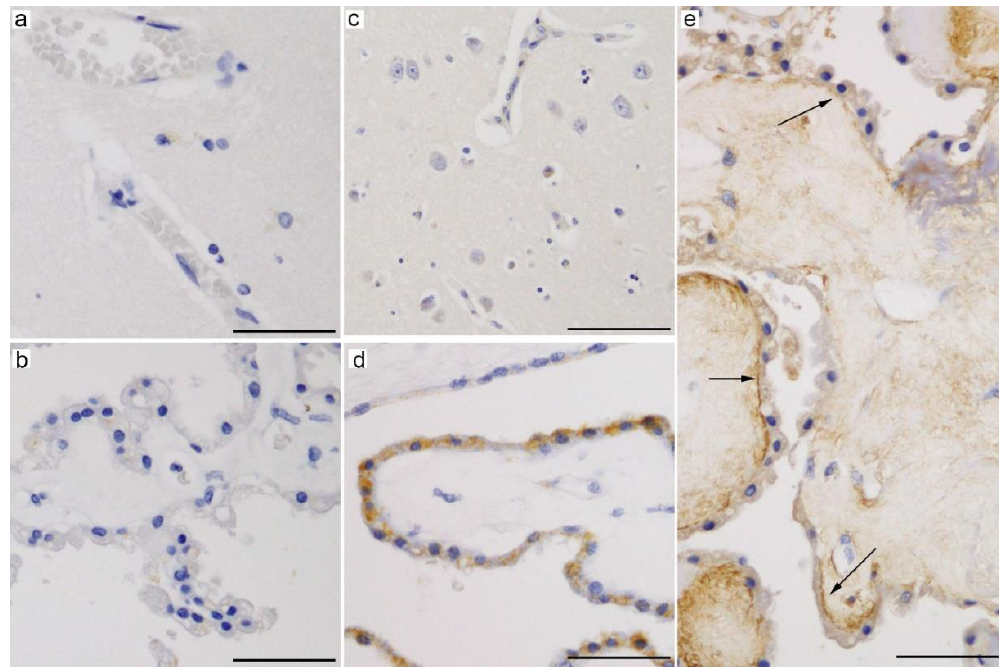
Figure 2. Representative microphotographs of immunohistochemical staining for ( a , b ) SGLT1 (ab14685, Abcam) [55], ( c , d ) SGLT2 (NBP1-92384, Novus Biologicals, Centennial, CO, USA) [55], and ( e ) SGLT2 (ab85626, Abcam, 5 μg/mL, antigen retrieval with citrate buffer (pH 6)) in autopsied human brains. Endothelial cells of brain microcapillaries express neither SGLT1 ( a ) nor SGLT2 ( c ). CP epithelial cells are devoid of SGLT1 immunoreactivity ( b ). In contrast, SGLT2 is expressed in CP epithelial cells, with an intracytoplasmic granular pattern ( d ), or along the plasma membrane of the basal side ( e , arrows), depending on the antibodies used. Scale bars: 50 μm.